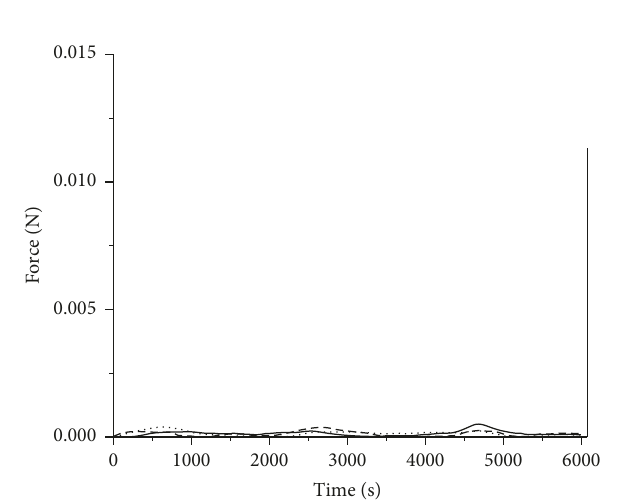
Figure 26: Dynamic curves of the spacecraft’s center of mass.